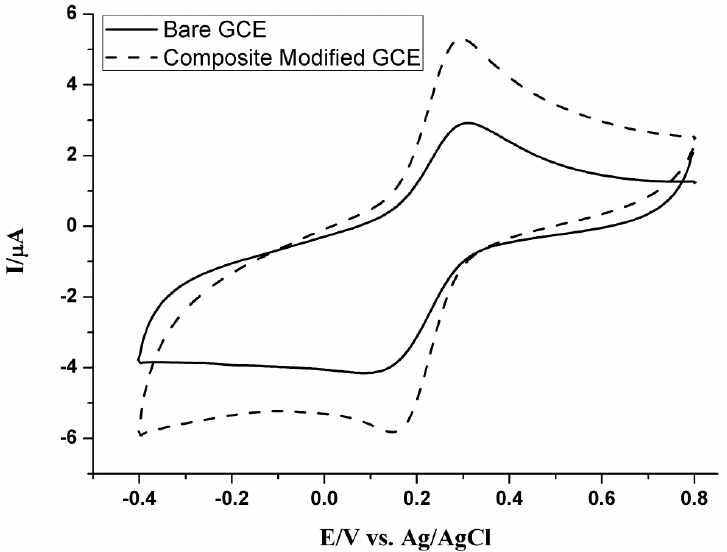
Figure 2. Cyclic voltammograms of 1.0 mM K 3 Fe(CN) 6 in 0.2 M KCl on bare GCE and PPy-MWCNTs/GCE at a scan rate of 20 mV s − 1